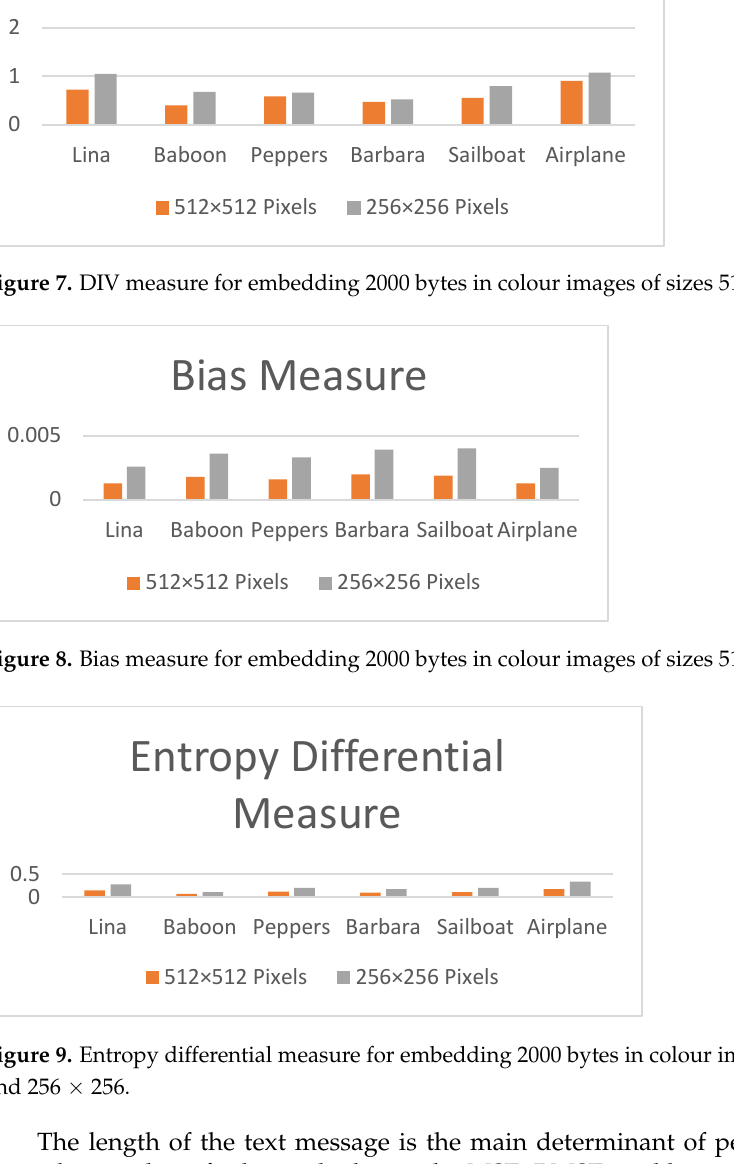
Figure 6. SSIM measure for embedding 2000 bytes in colour images of sizes 512 × 512 and 256 × 256.